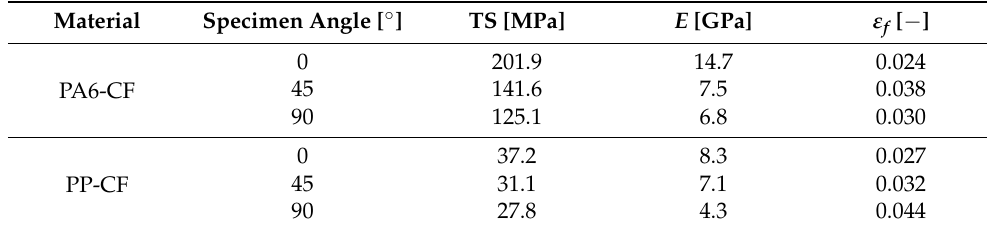
Table 3. Mechanical properties of PA6-CF and